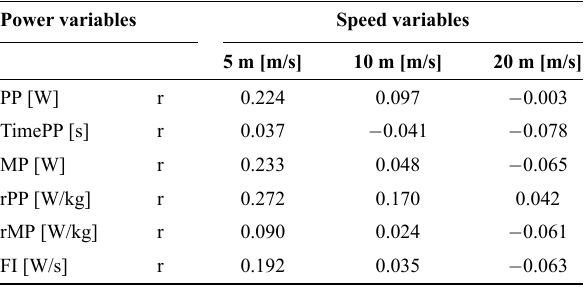
Table 2 - Correlation coefficient between the results of the WAnT and the results of the 20-m sprint test (n = 11). Power variables